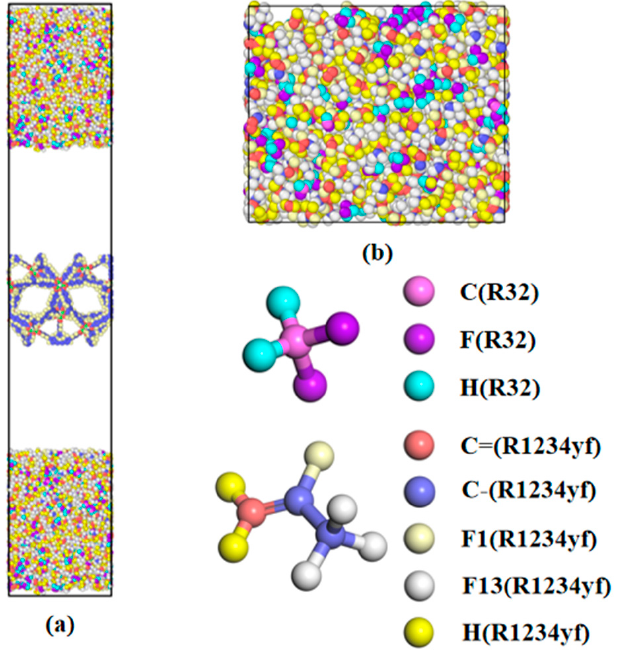
Figure 1. Initial composition of the simulation system. ( a ) Adsorption model; ( b ) diffusion model. Table 1. Number of molecules in mixed refrigerant system.